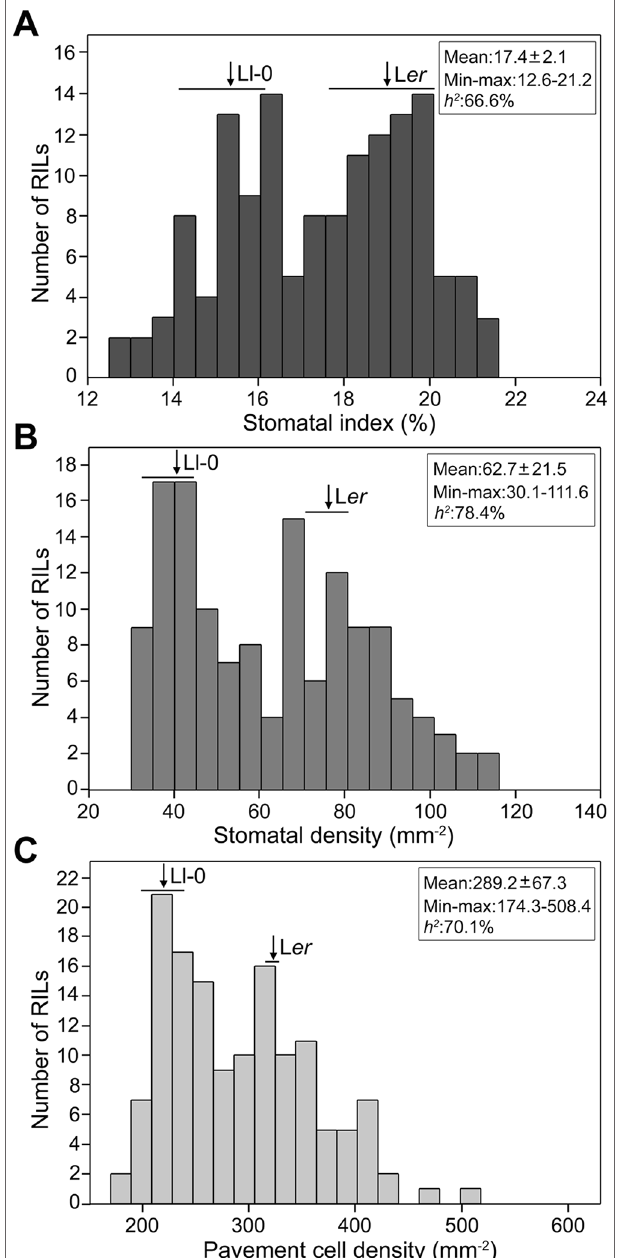
FIGURe 2 | Frequency distributions of stomatal abundance traits in the L er x Ll-0 (RIL)population. Stomatal index (A) and density (B) and pavement cell density (C) were scored in mature adaxial cotyledon epidermis of green- house grown plants. Arrows and horizontal bars mark mean ± SD of parental lines. The population mean, the minimum and maximum RIL means, and the broad sense heritability ( h 2 ) of traits are indicated inside each panel.